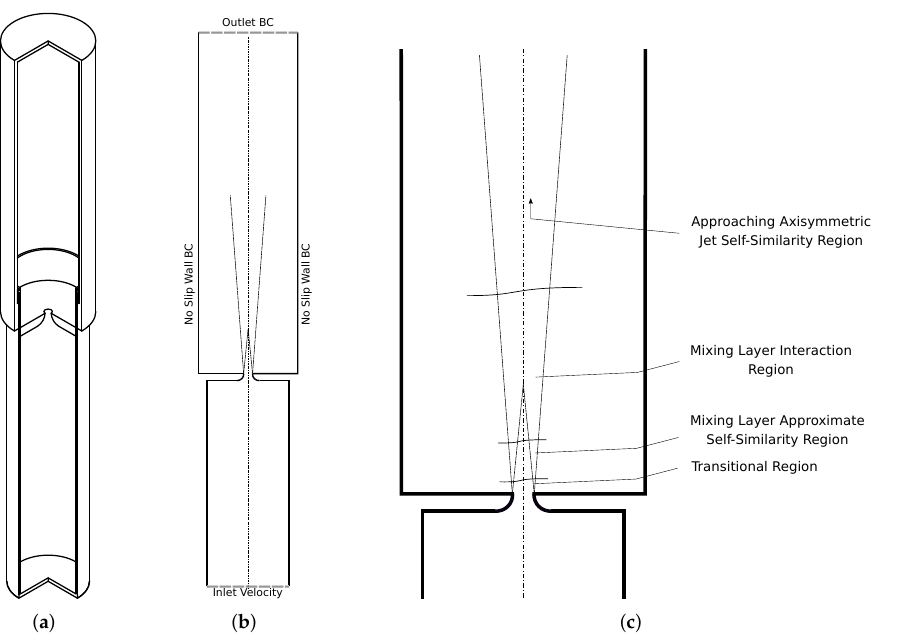
Figure 1. Shock absorber geometry and some setup details ( a ) Schematic view of the simplified shock absorber geometry; ( b ) The computational domain with the applied boundary conditions; ( c ) Axisymmetric shear layer development regions, following Bradshaw et al. [11]. Table 1. Case details for the scale-resolving 3D axisymmetric free shear layer simulation. Simulation Parameter